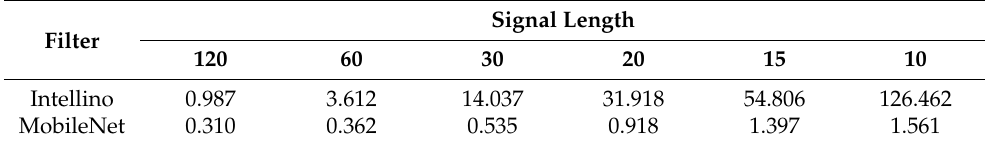
Table 5. Inference time of Intellino and MobileNet with WA filter [ms].